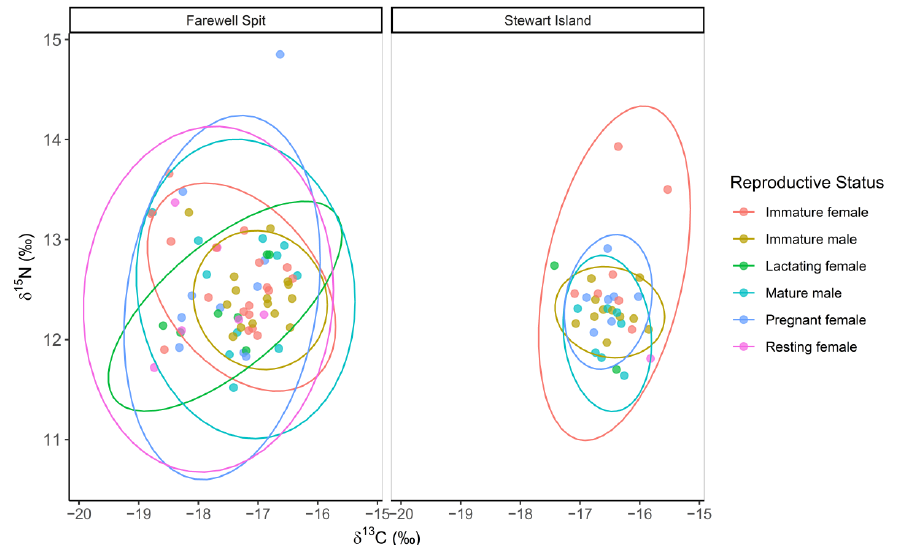
Figure 3. Isotopic niche overlap of carbon and nitrogen ( δ 13 C and δ 15 N) isotopic values of long-finned pilot whales ( Globicephala melas edwardii ) with immature female ( n = 25), immature male ( n = 26), lactating female ( n = 9), mature male ( n = 18), pregnant ( n = 17) and resting ( n = 7) females presented by stranding location on the New Zealand coast, 2009–2017. Ellipses represent 95% of data. Sulphur isotope values did not differ significantly between stranding events (Kruskal– Wallis, ts = 9.24, p = 0.10) nor stranding location (FWS: 21.33 ± 0.95‰, n = 32; SI: 21.61 ± 0.82‰, n = 18; Kruskal–Wallis, ts = 0.65, p = 0.42; Figure